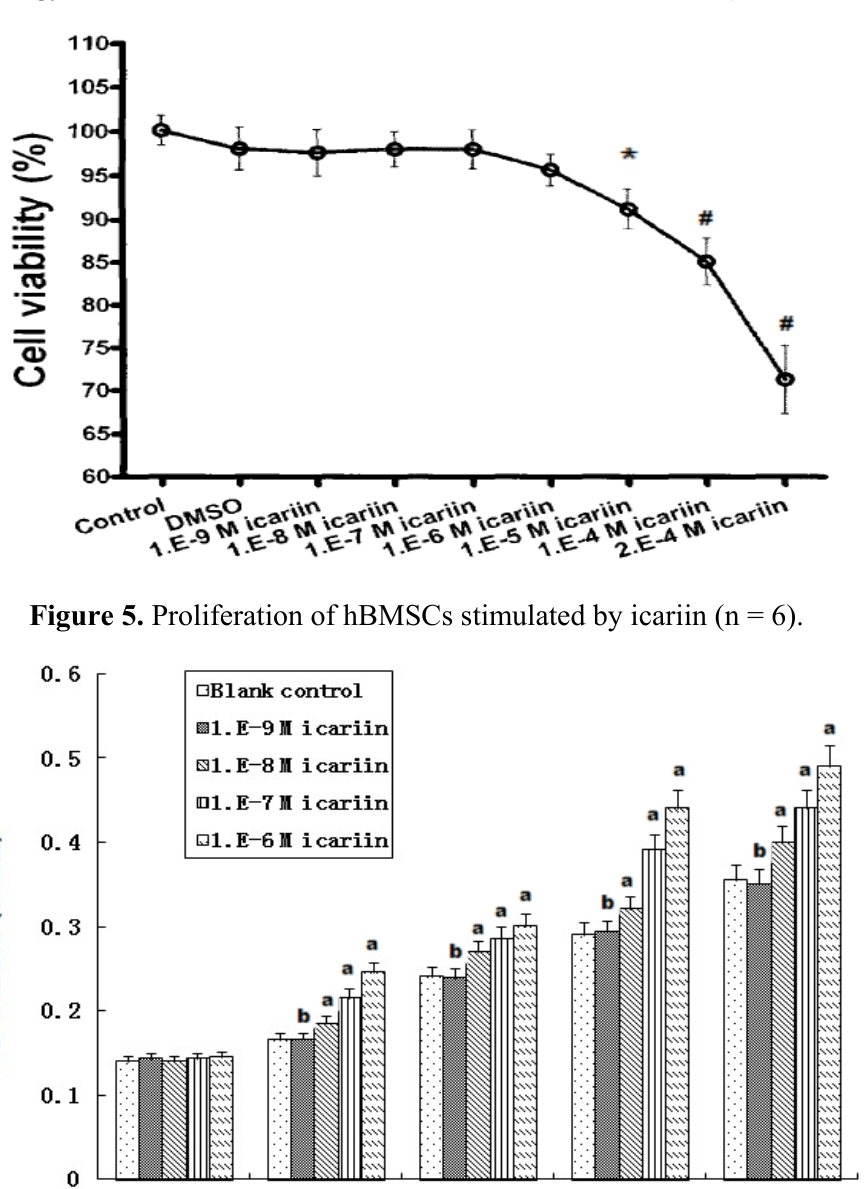
Figure 4. Toxicology of different concentrations of icariin toward hBMSCs (Cell viability %) (n = 6).